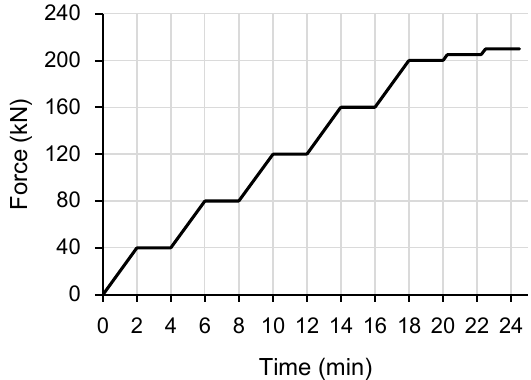
Figure 8. Load profile of the tension test.